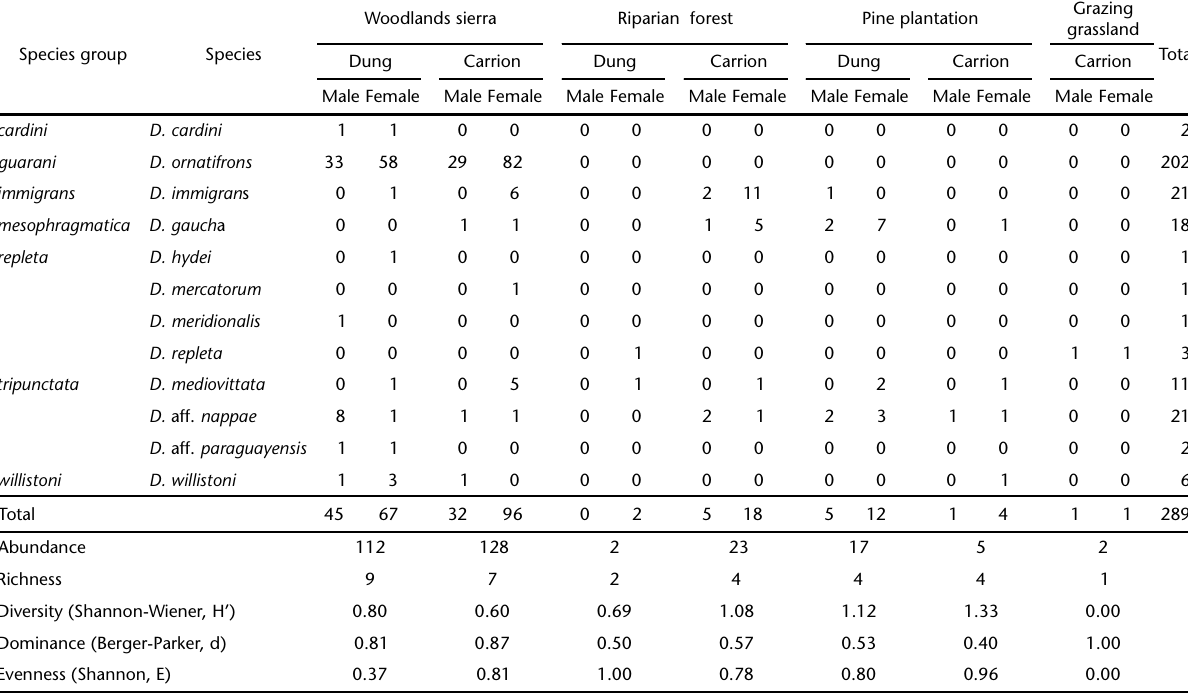
Table II. Species richness, abundance of Drosophila spp. and ecological indexes calculated for each habitat surveyed at the Sierra de Minas, Department of Lavalleja, Uruguay, from May 2002 to April 2003. Dung (D) and carrion (C) baited pitfall traps.